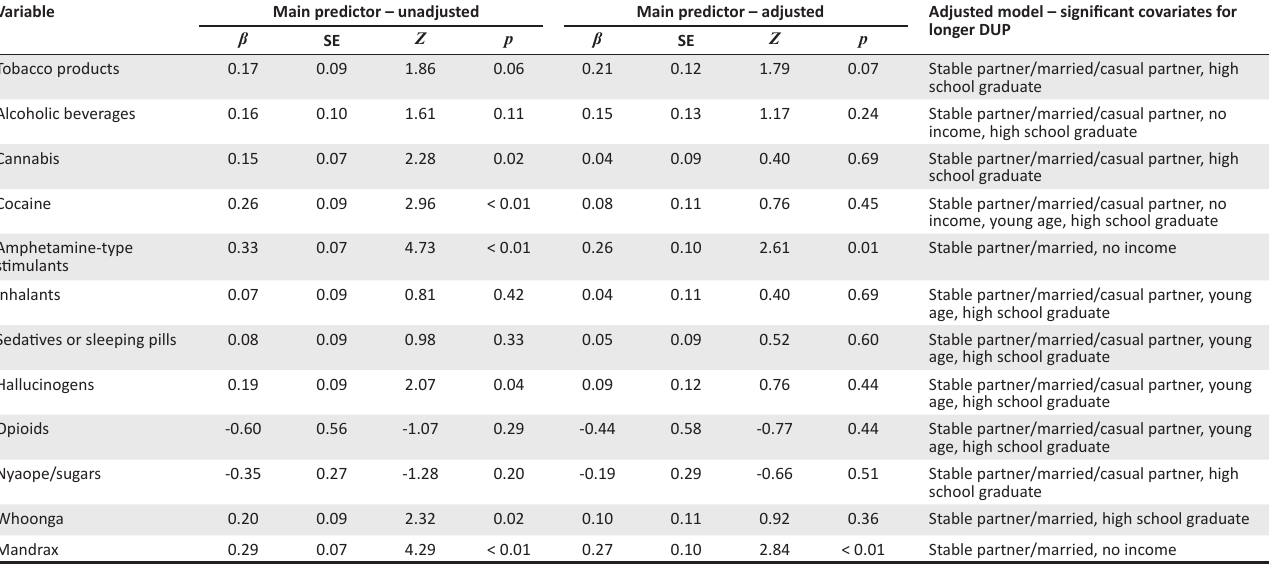
TABLE 4: Unadjusted and adjusted regression analysis between Alcohol, Smoking and Substance Involvement Screening Test and duration of untreated psychosis (DUP) for lifetime substance use. Variable Main predictor – unadjusted Main predictor – adjusted Tobacco